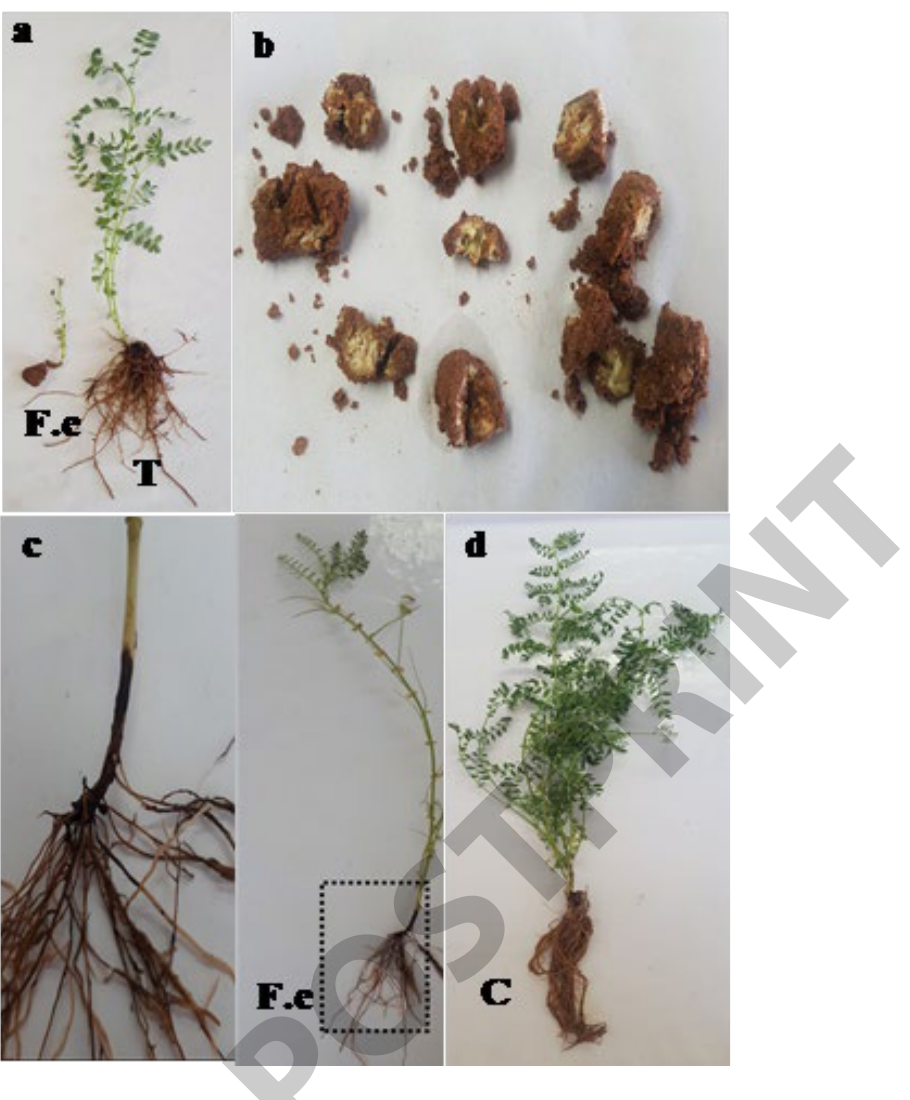
Fig. 2. Symptoms of stunting in chickpea plants ( a ) derived from seeds inoculated with Fusarium equiseti isolate (F.e) and control seedlings from non-inoculated chickpea seeds (T); b : symptoms of rot in inoculated chickpea seeds; c : brownish discoloration of crown in chickpea plants grown in F. equiseti -infested soil (F.e); d : chickpea plants grown in un-infested soil